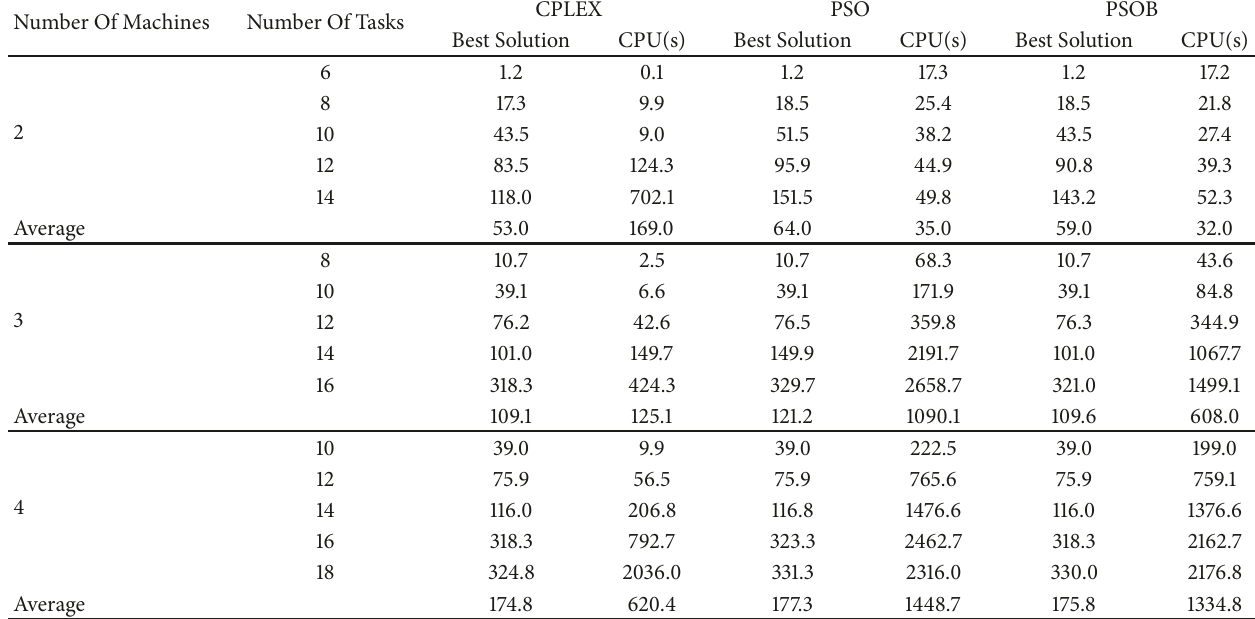
Table 5: Computational experiments of solving small-scale instances by CPLEX, PSO, and PSOB algorithms. Number Of Machines